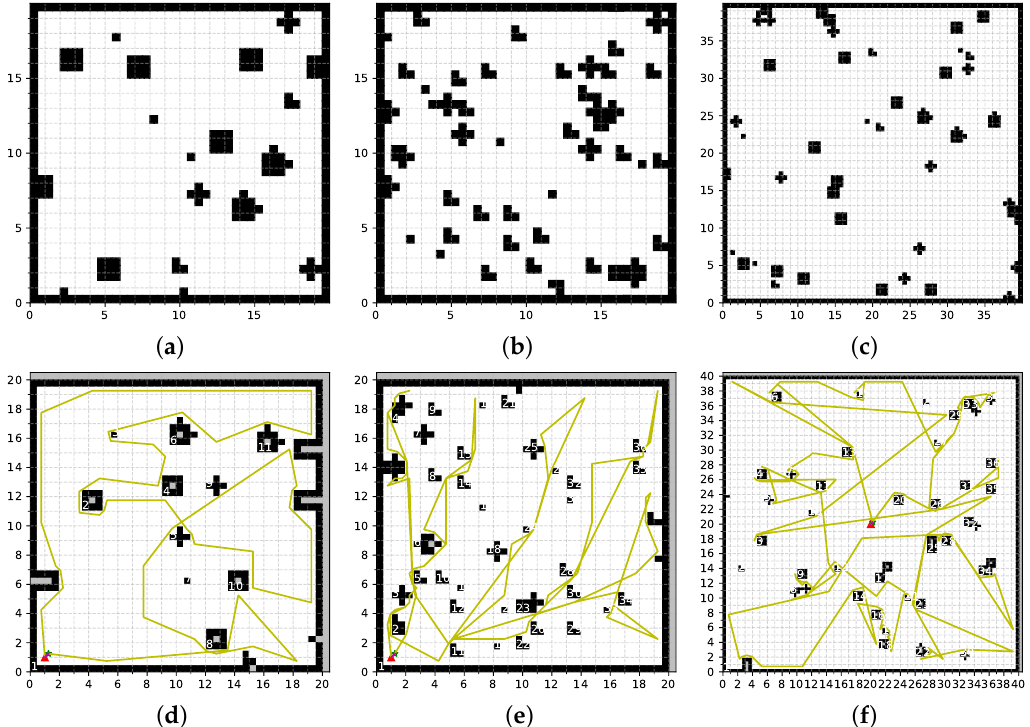
Figure 4. Typical randomized environments used in simulations. Shown are typical configurations for low-density environment ( a ), high-density environment ( b ) and large environment ( c ), as well as example paths taken to explore them, shown in ( d – f ),